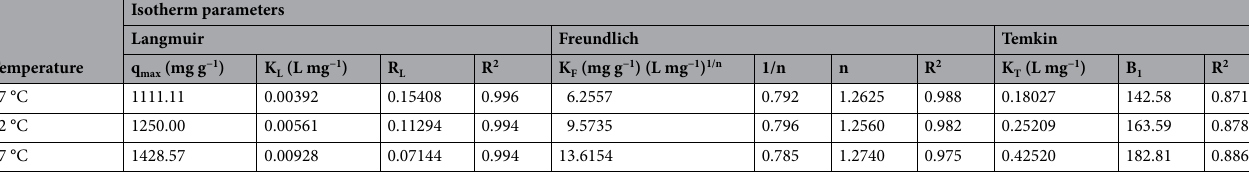
Table 2. Isotherm constants of Langmuir and Freundlich and Temkin models for KMnO 4 adsorption by Ox-FVESP.